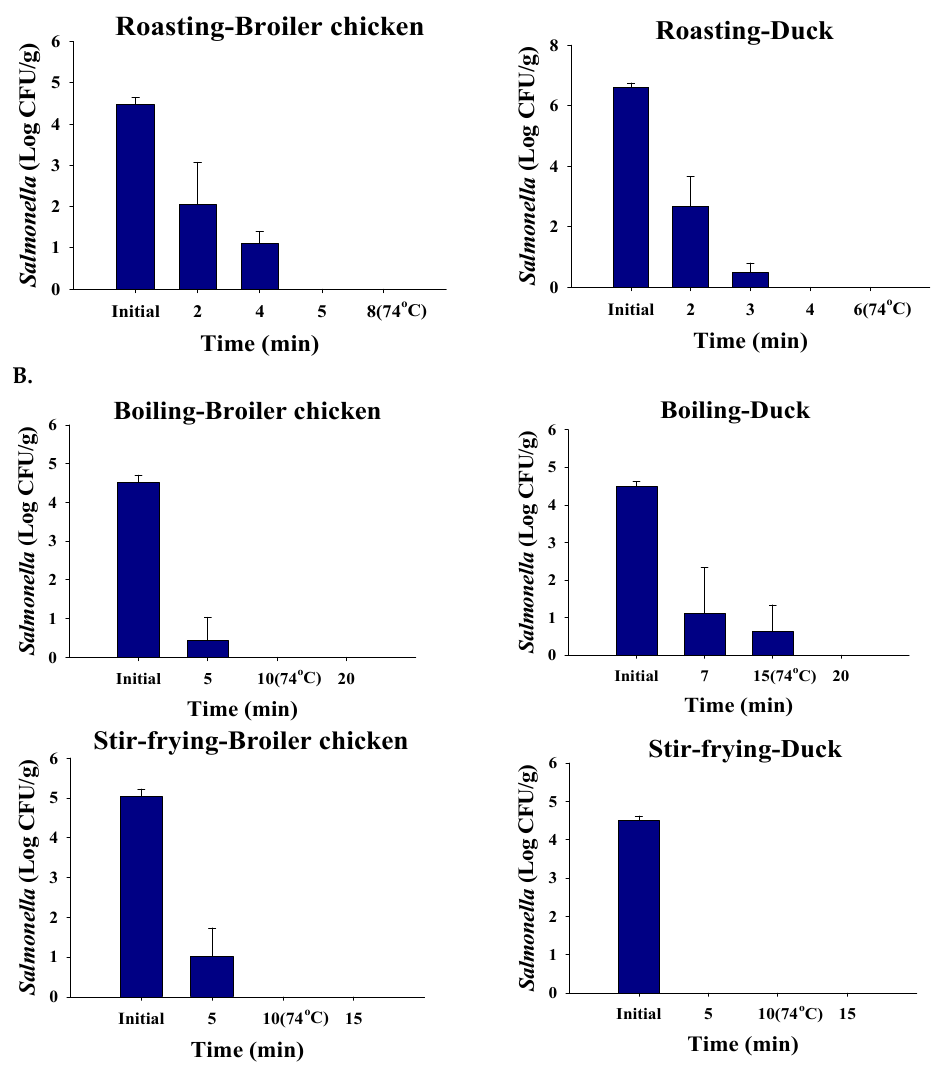
Figure 4. Methods of cooking shown to reduce Salmonella cell counts. ( A ) dry-heat cooking, ( B ) moist-heat cooking.